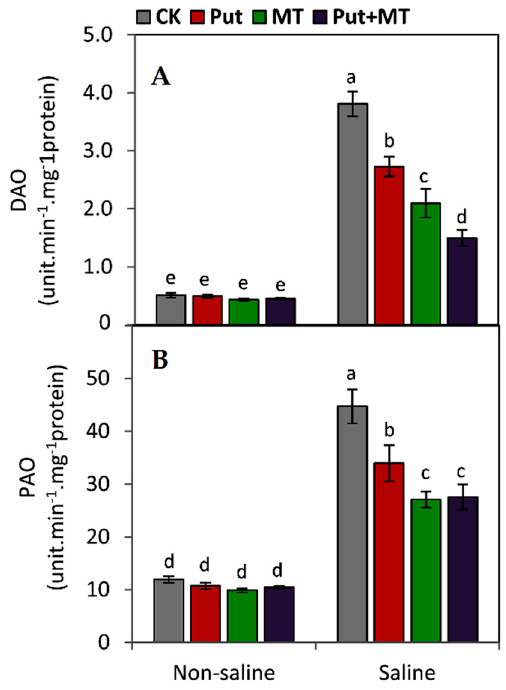
Figure 6. Effect of melatonin (MT; 20 µ M), putrescine (Put; 100 µ M), and their combination on the oxidation of polyamines of snap bean seedlings grown under control and salt stress (50 mM NaCl). ( A ) Diamine oxidase (DAO) and ( B ) polyamine oxidase (PAO). The upper error bar denotes standard deviation, while various lowercase letters above the bars denote significant differences according to Duncan’s multiple range tests ( p ≤